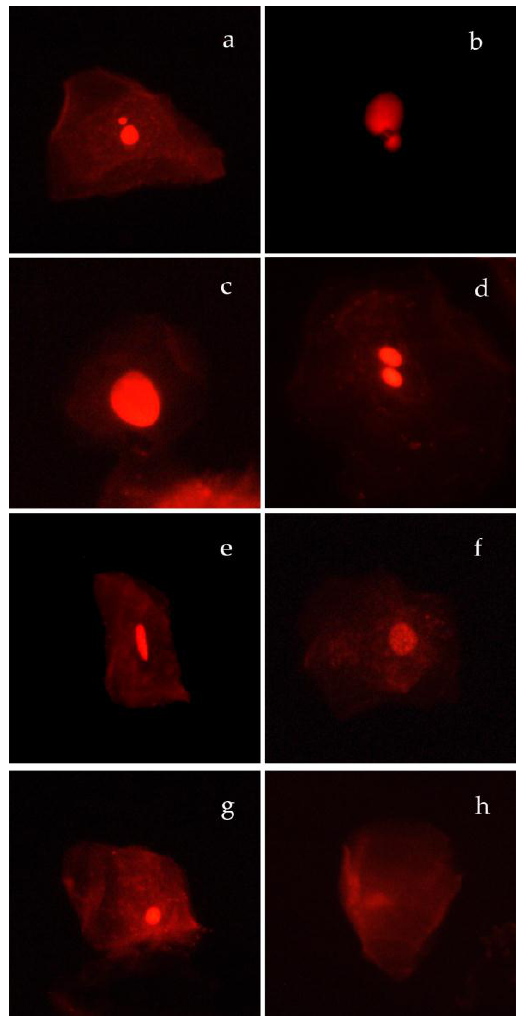
Figure 2. Cell types classified according to Bolognesi et al. [38]: ( a ) Cell with a micronucleus (MNC); ( b ) cell with a nuclear bud (NBUD); ( c ) basal cell (BC), ( d ) binucleated cell; (BNC); ( e ) condensed chromatin cell (CCC); ( f ) karyorrhectic (KHC); ( g ) pyknotic (PYK); ( h ) karyolytic (KYL).